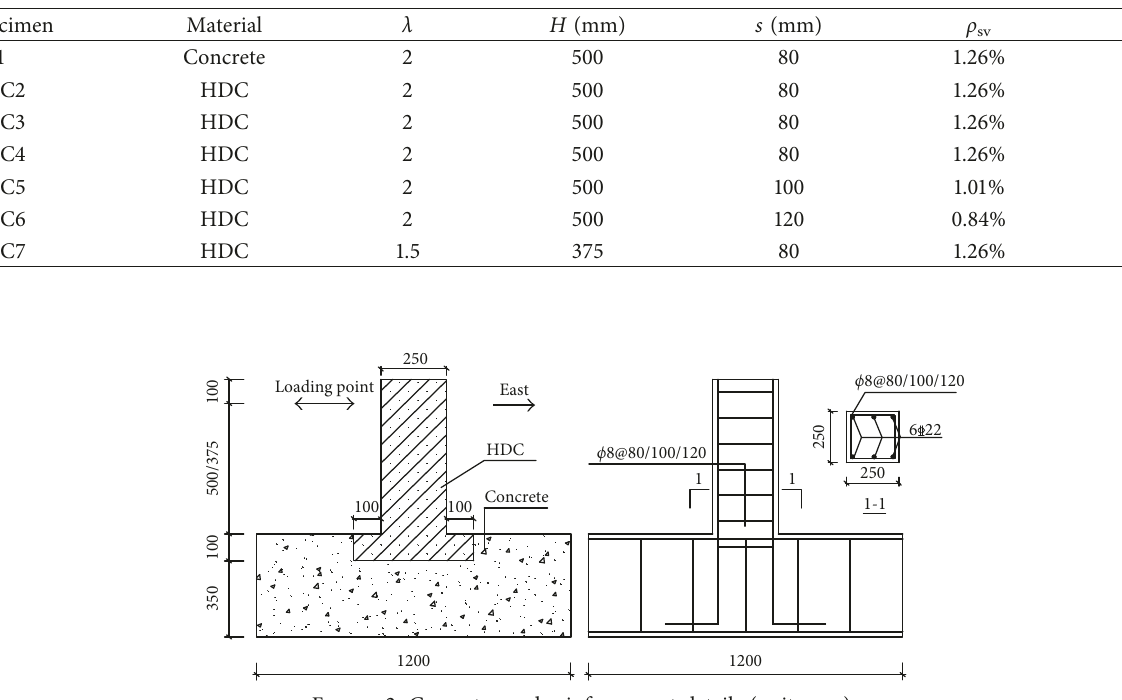
Table 3: Parameters of short